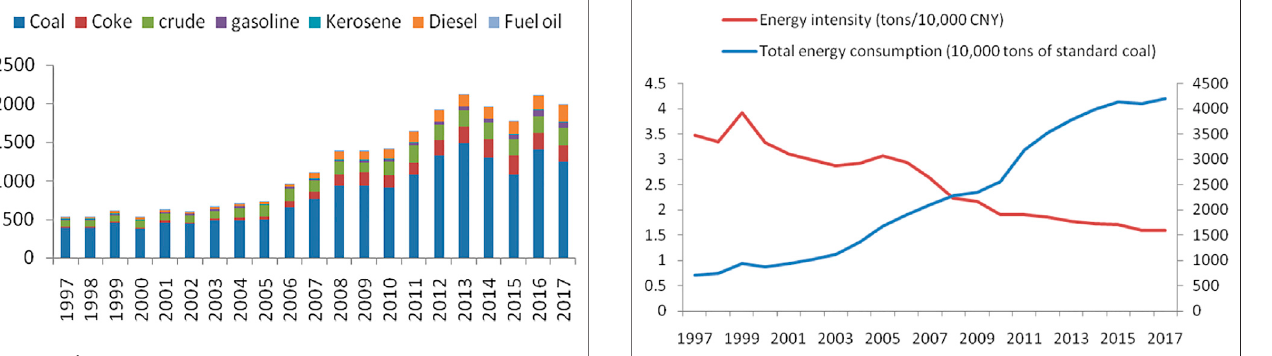
FIGURE2| ThecompositionofenergyconsumptioninQinghaiProvince (10 thousand tons of standard coal).